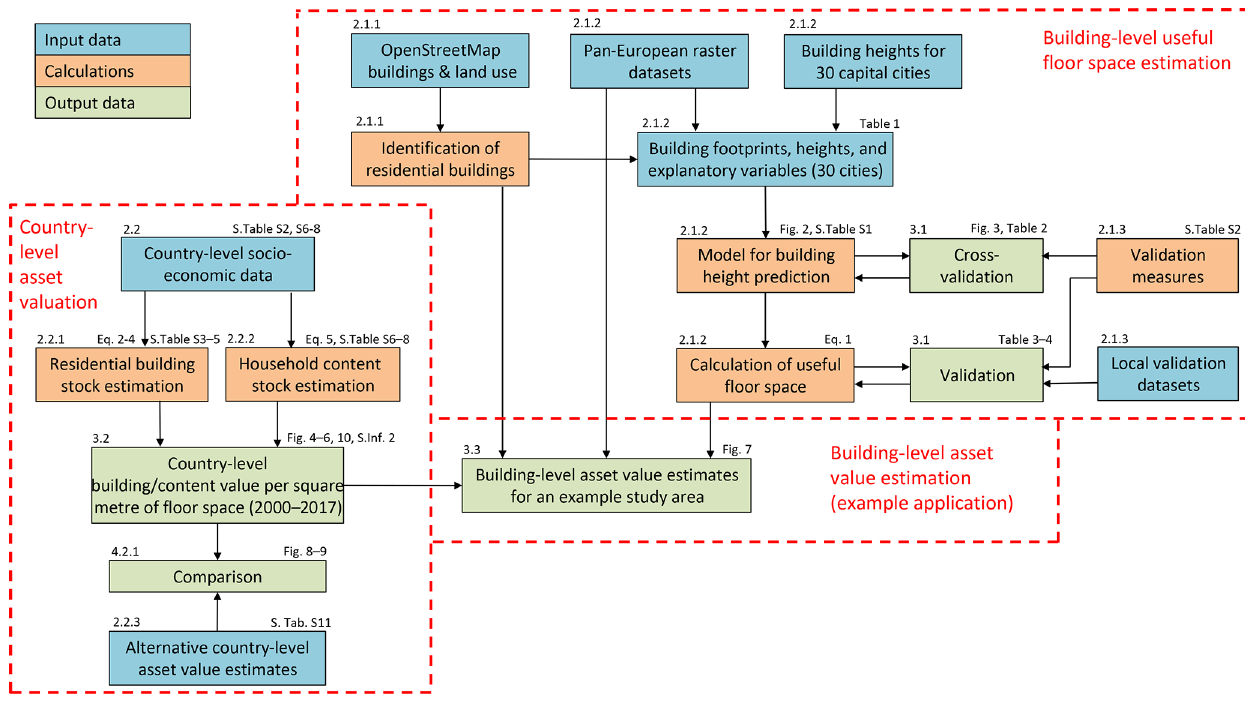
Figure 1. Workflow of the study. Boxes are coloured according to categories explained in the legend. In the top left corners of the boxes are references to relevant sections of this paper. In the top right corners of the boxes are references to figures, tables, supplementary tables (S.Tab.) in Supplementary Information 1, equations, and Supplementary Information 2 (S.Inf.